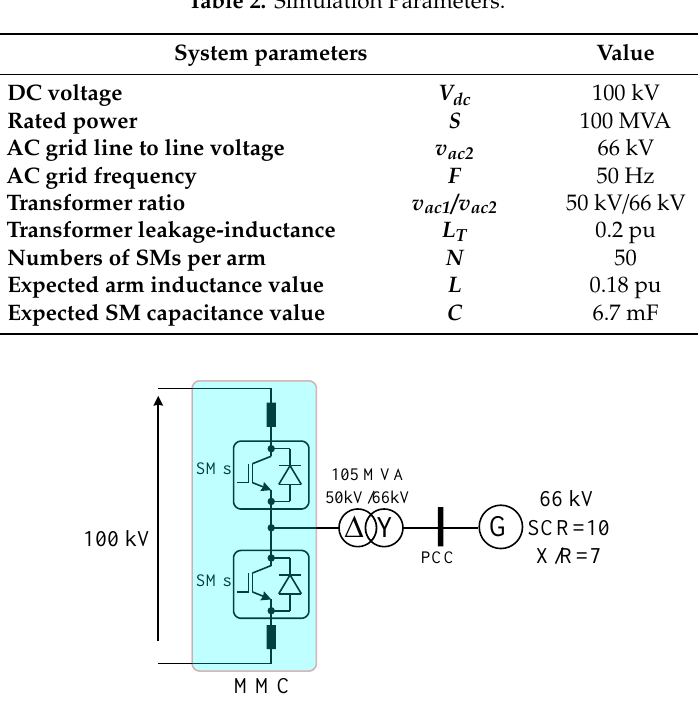
Figure 12. Test system employed in parametric studies with a 50-cell MMC, in which 5 faulty SMs represent 10% of the total number of SMs per arm. Table 2. Simulation Parameters.